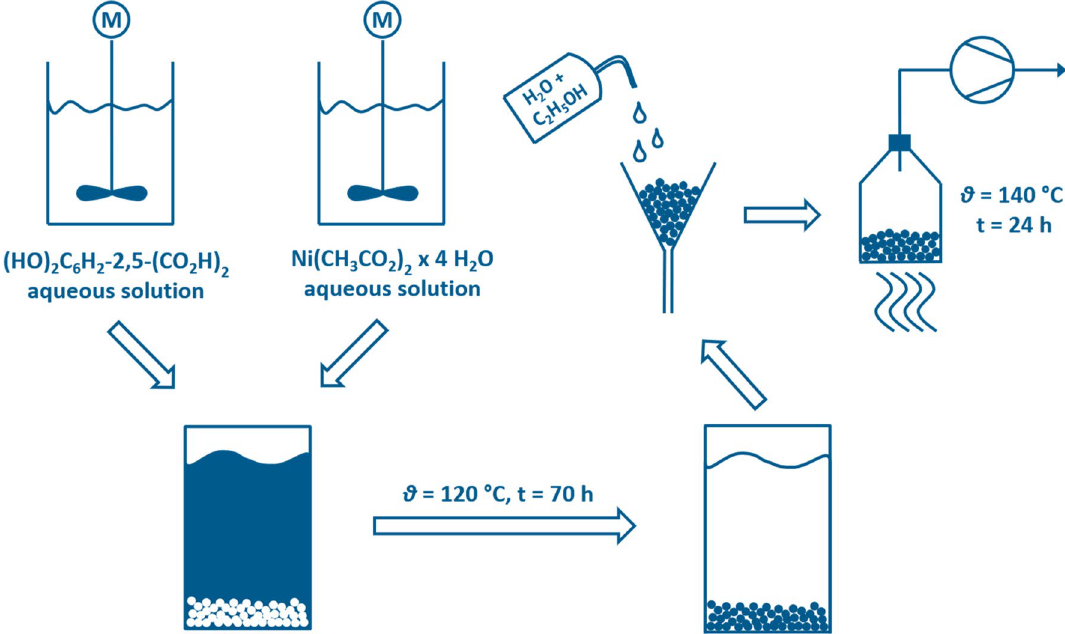
Fig. 1 Schematic for the synthesis of Ni-MOF-74@Al